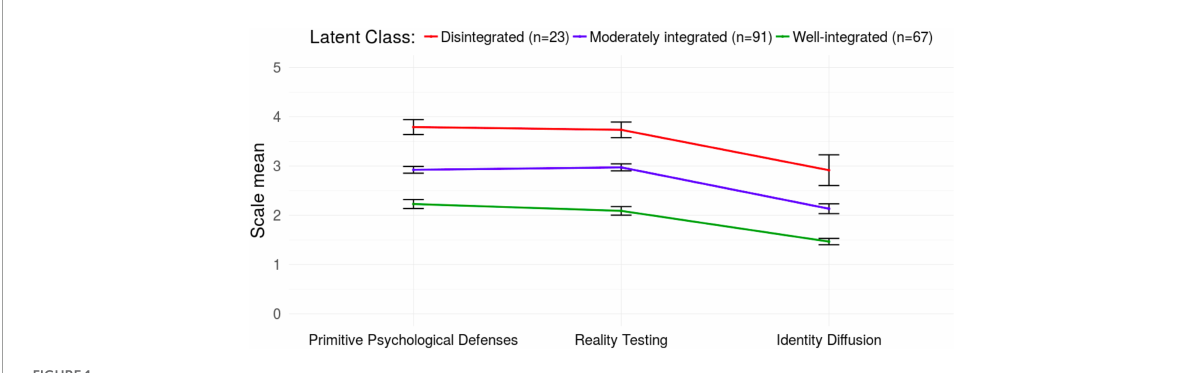
differences on the IPO primary factors between latent